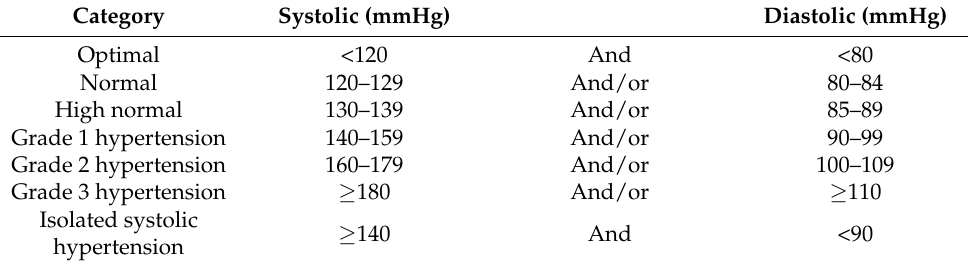
Table 1. Classification of office BP and definitions of hypertension